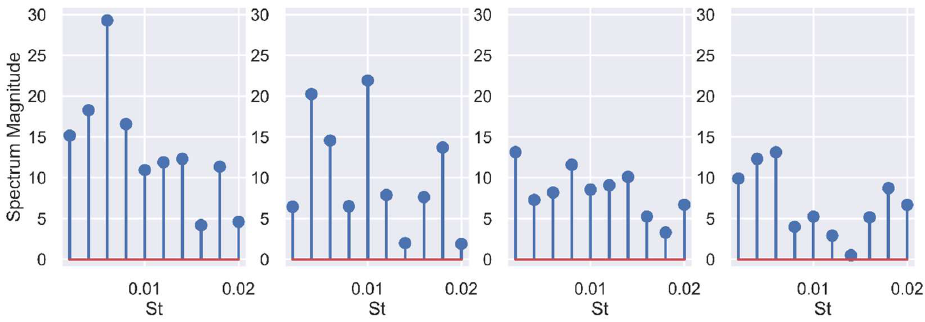
Figure 14. The spectrum analysis on the signals in Figure 13.